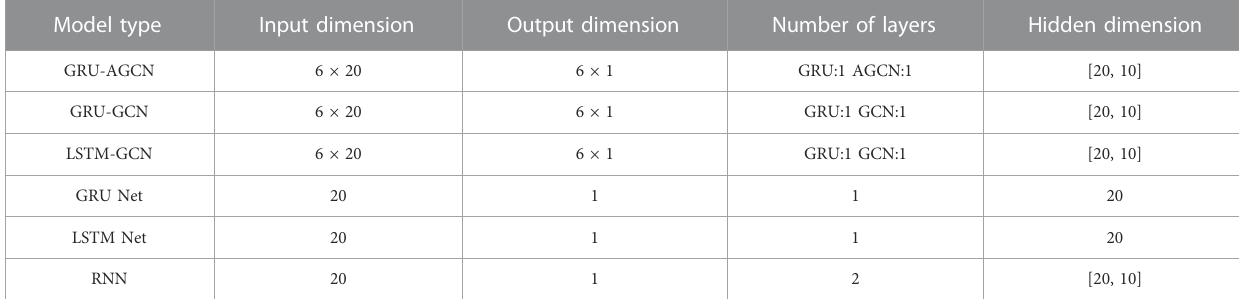
TABLE 2 Parameters of prediction models.